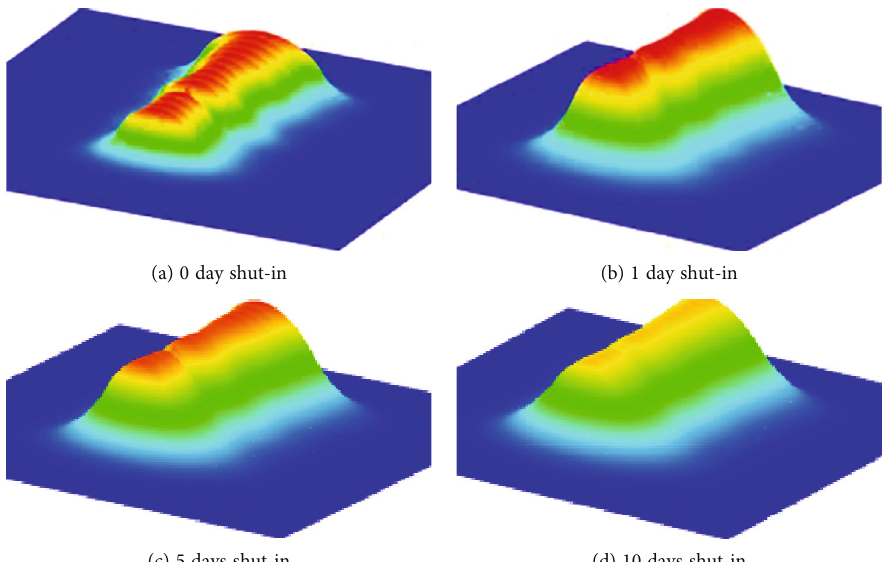
Figure 14: Formation pressure distribution for di ff erent well shut-in times.